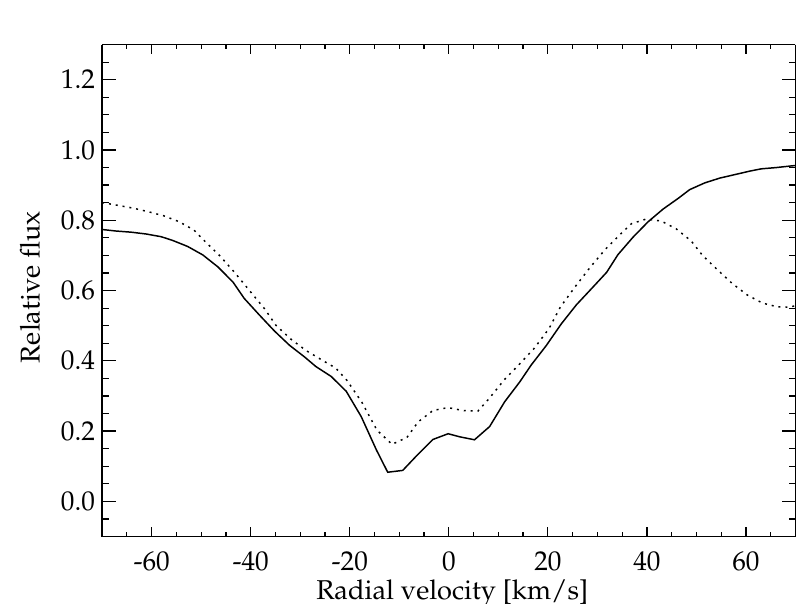
Fig. 3. The Ca II H and K lines in the spectrum of υ Sgr in the velocity scale. The K line is plotted by continuous line, the H line { by dotted line. The pro(cid:12)les are from the mean NARVAL spectrum. Plotted are only central parts of the lines to show the IS components.